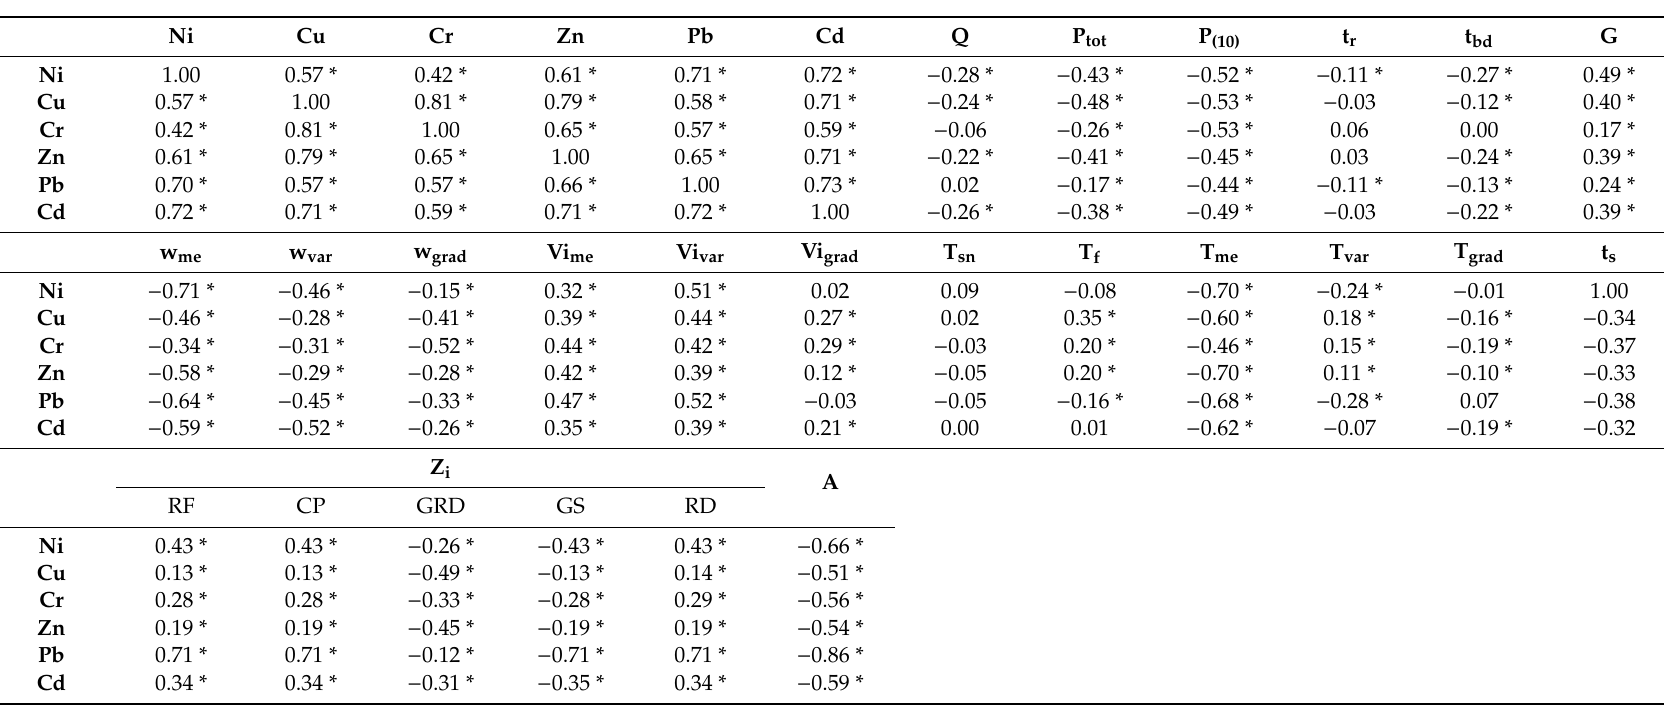
Table 3. Matrix of Pearson correlation coe ffi cients between selected heavy metal (HM) and catchment / atmosphere